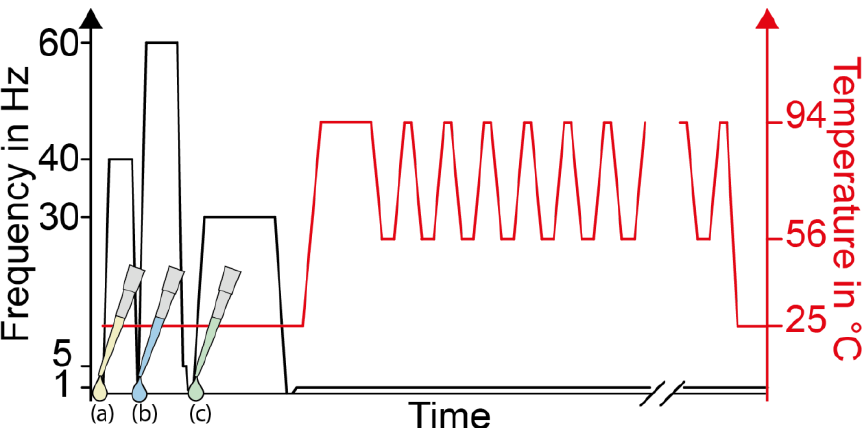
Figure 2. LabDisk frequency and temperature protocol for droplet generation and PCR thermo-cycling in LabDisk Player 1. During droplet generation, the temperature remained constant at room temperature (approximately 25 °C) and the frequency changed, whereas during PCR thermocycling, the frequency remained constant at 1 Hz. For oil transfer and droplet generation, the respective reagents were pipetted into the LabDisk manually, as indicated by a pipet tip (emulsification-oil = yellow (a), reaction mix = blue (b) and PCR-oil = green (c)).